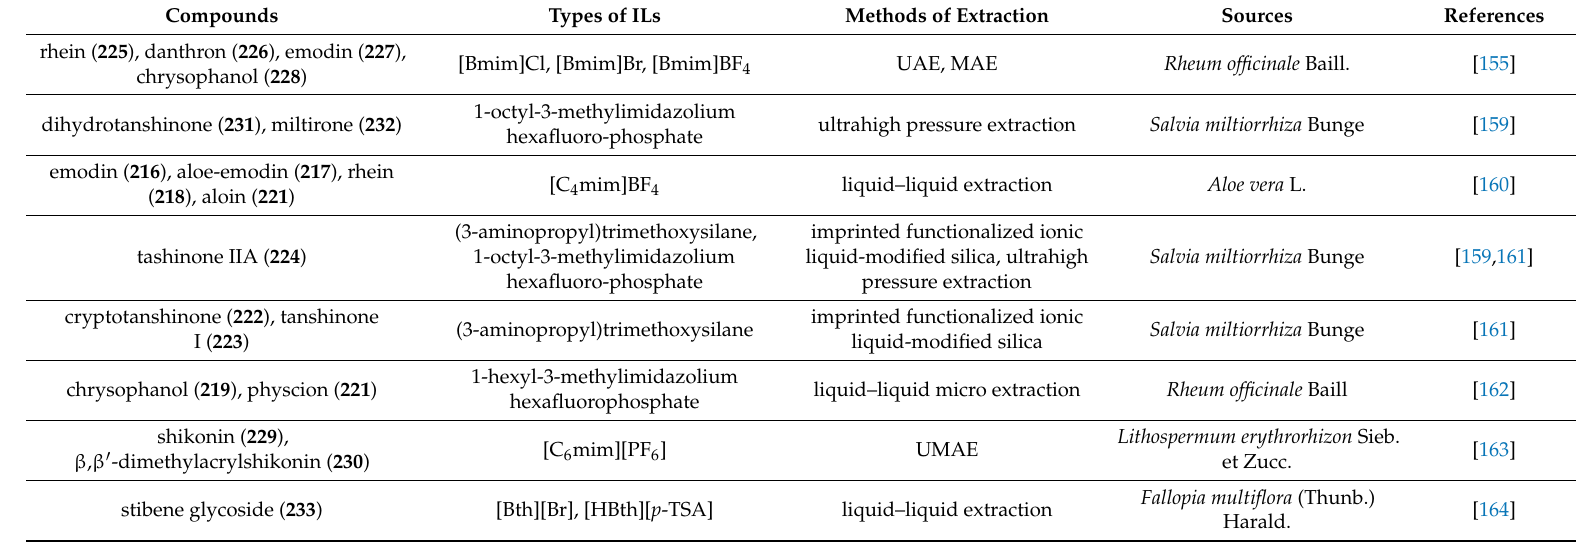
Table 8. The quinones extracted from natural sources using ILs or IL solutions by different extraction